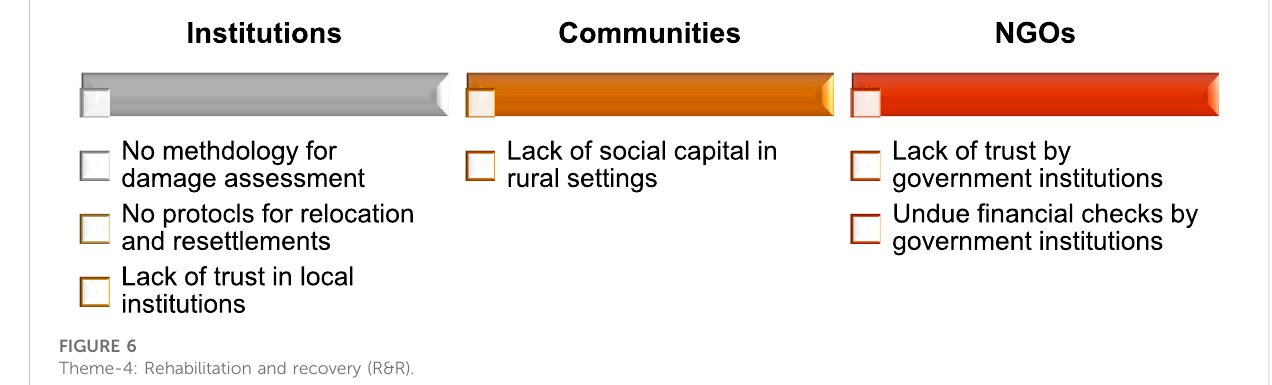
FIGURE 6 Theme-4: Rehabilitation and recovery